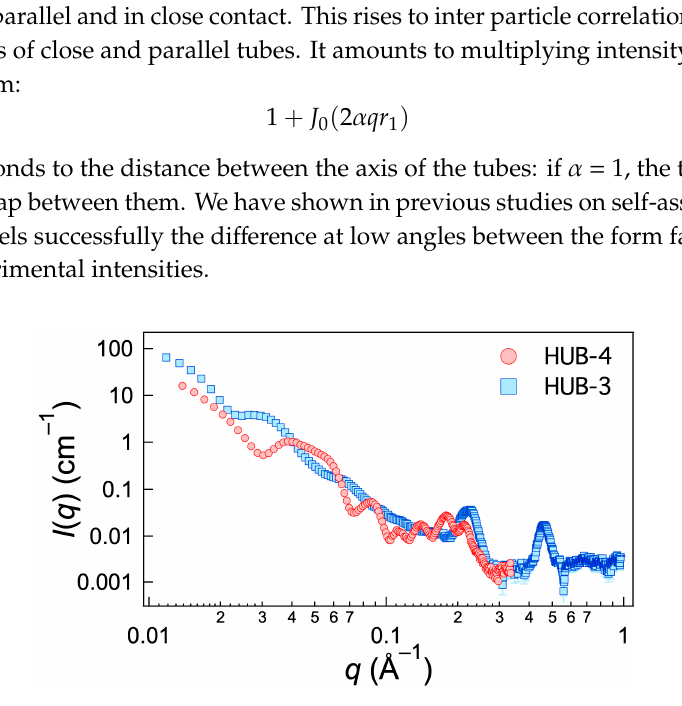
Figure 6. Intensities scattered by gels of HUB-3 and HUB-4 in cyclohexane (2 wt.%).